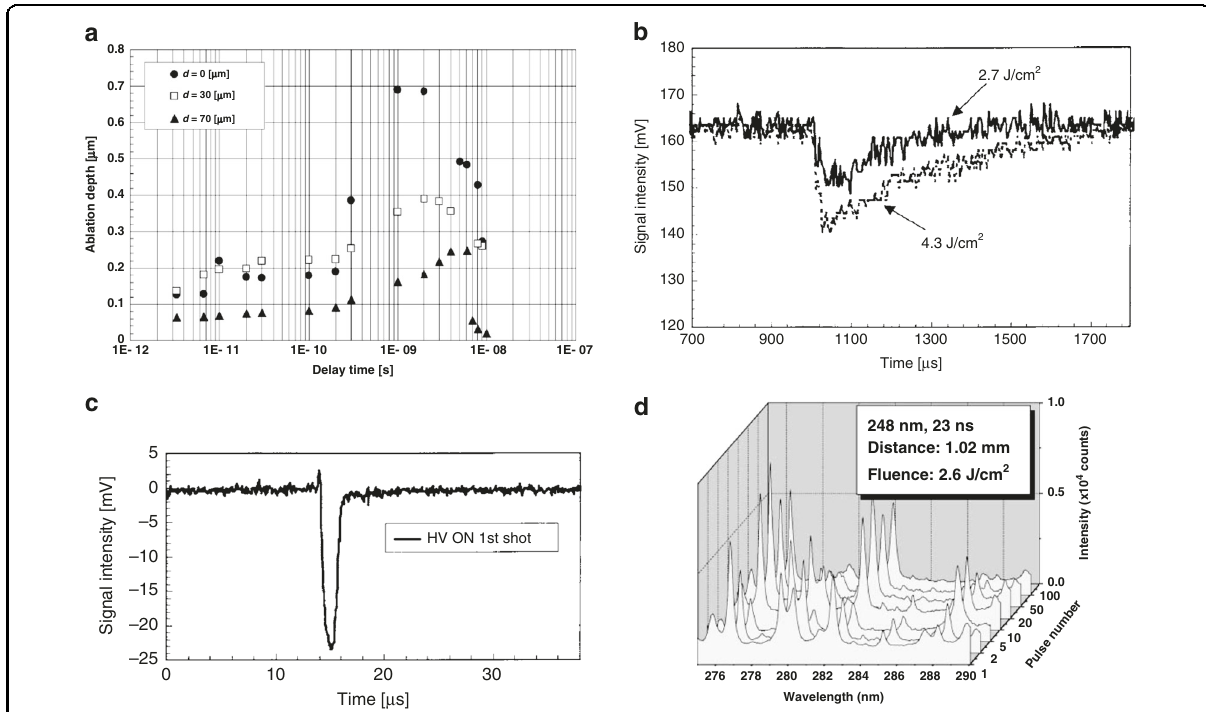
Fig. 2 Studies of the dynamic process of LIPAA. a Dependence of ablation depth on delay time between the 1st and the 2nd pulses for target-to- substrate distances of 0, 30, and 70 μ m 57 . b Transient absorption enhancement of the substrate due to the laser-induced plasma at laser fl uences of 2.7 and 4.3 J/cm 2 . The target-to-substrate distance is 12 mm 58 . c Plasma-conductivity signal observed in fused silica irradiated with an F 2 laser, indicating that electron – hole pairs are formed 58 . d Optical emission spectra during the KrF excimer LIPAA of fused quartz at a target-to-substrate distance of 1.02 mm and a laser fl uence of 2.6 J/cm 2 . At the fi rst pulse, the quartz spectral line intensity is almost zero, indicating there is no laser ablation of the substrate 60 . Figure a reproduced with permission from ref. 57 ,2005 Elsevier B.V. All rights reserved; b , c from ref. 66 , © 2006